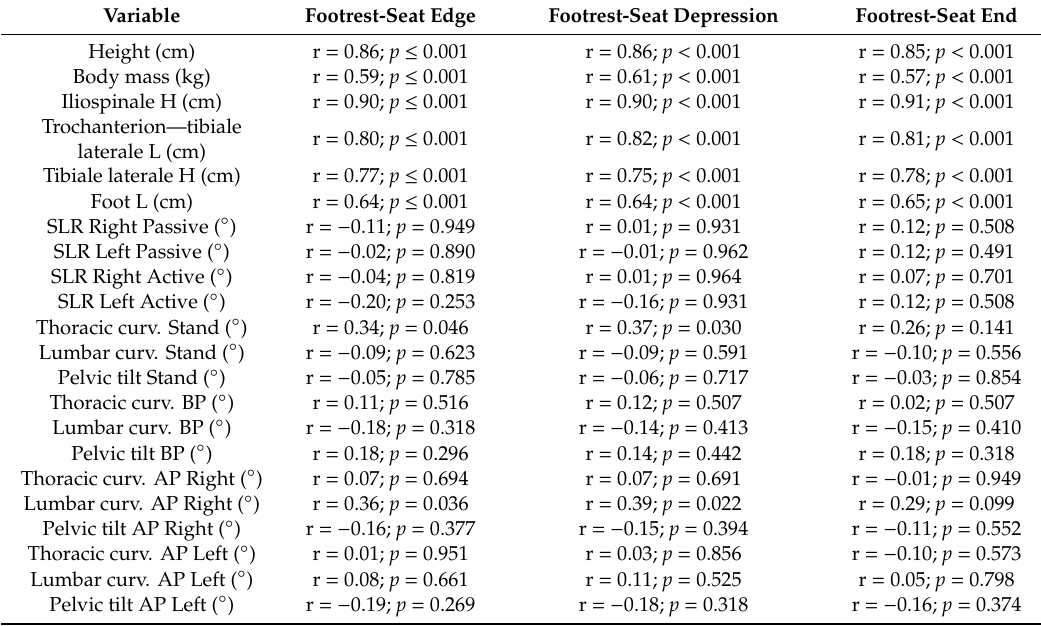
Table 3. Correlations between the placement of the material and the anthropometric variables. Variable